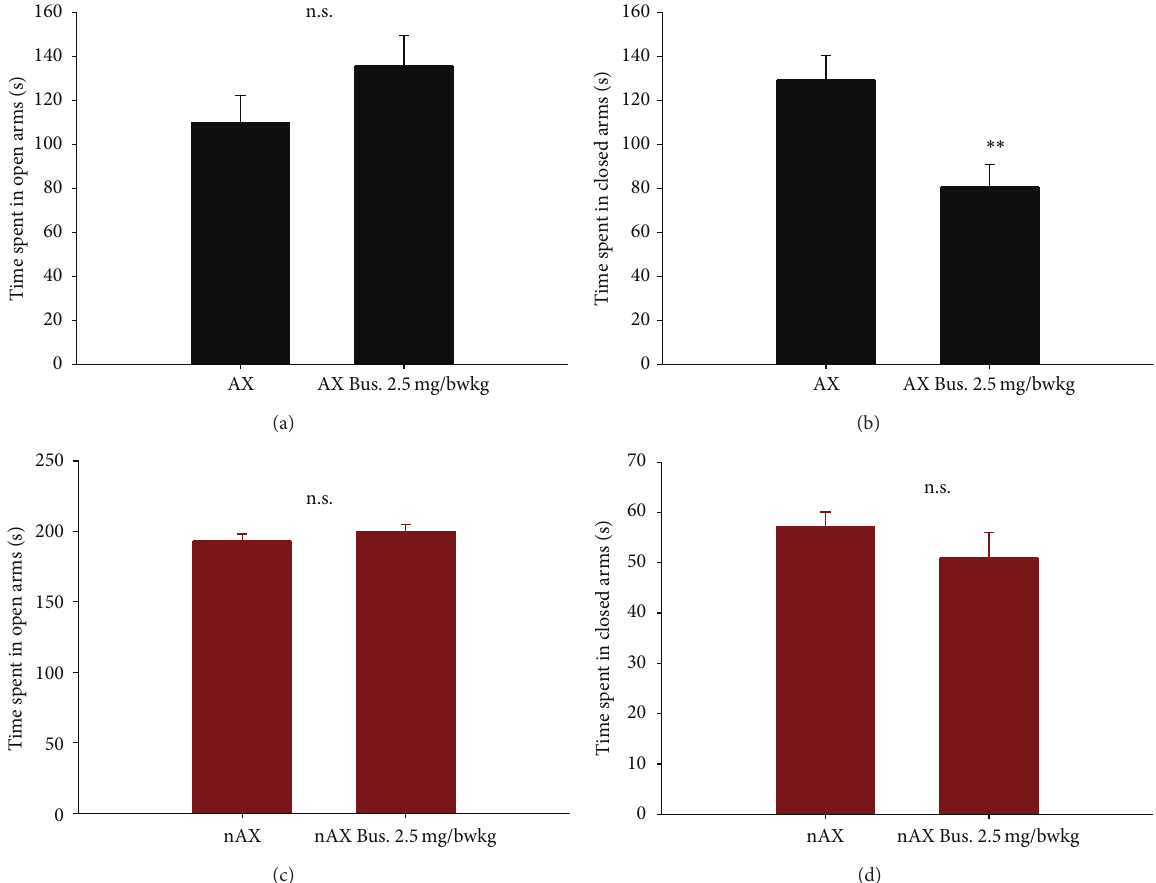
Figure 1: Buspirone decreased anxiety of AX mice in the elevated plus maze. A nonsignificant increase in the time spent in the open arm (a) and a significant decrease in the time spent in the closed arm (b) were induced by buspirone. There was no effect of buspirone treatment on nAX mice neither in the time spent in the open (c) nor in the closed (d) arm. ** 𝑃 ≤ 0.01 , 𝑡 -test.